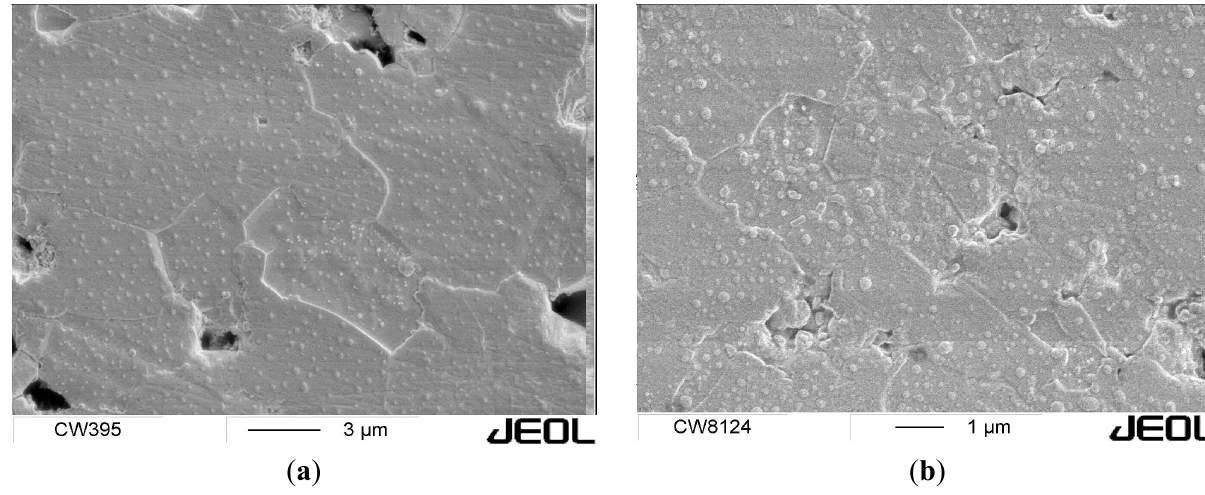
Figure 1. Microstructure refinement observed in Al 2 O 3 -SiC nanocomposites